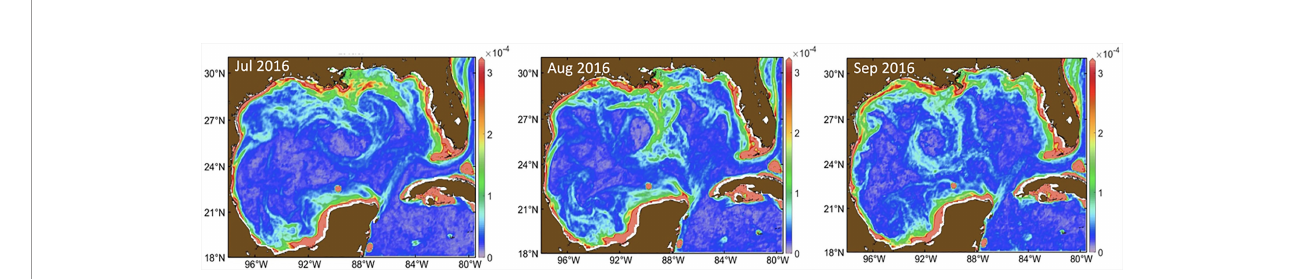
FIGURE 4 | Distributions of surface chlorophyll a fronts (using a color index as the proxy) in July – September 2016 showing offshore advection and entrainment of nutrient-rich coastal and shelf waters by anti-cyclonic eddies, which in fl uences both the eastern and western Gulf of Mexico. Figure adapted from Zhang and